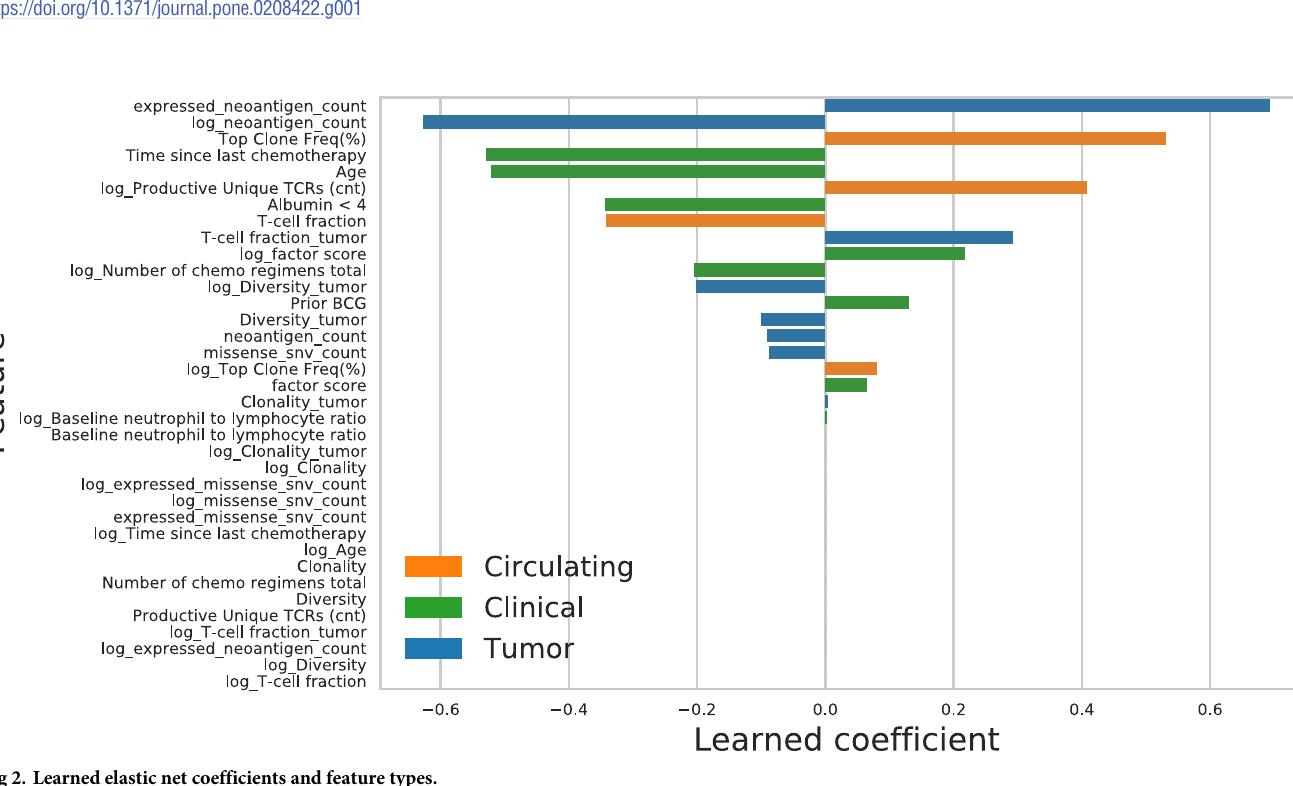
Fig 2. Learned elastic net coefficients and feature